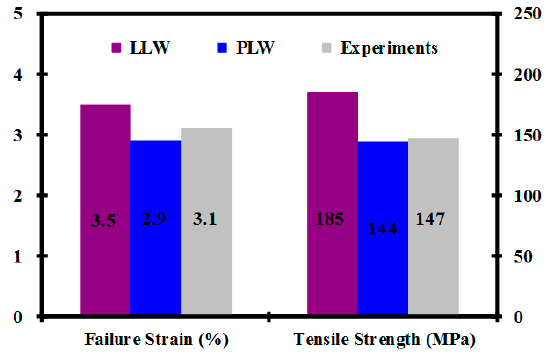
Figure 2. Composite tensile properties predicted by the Weibull model.